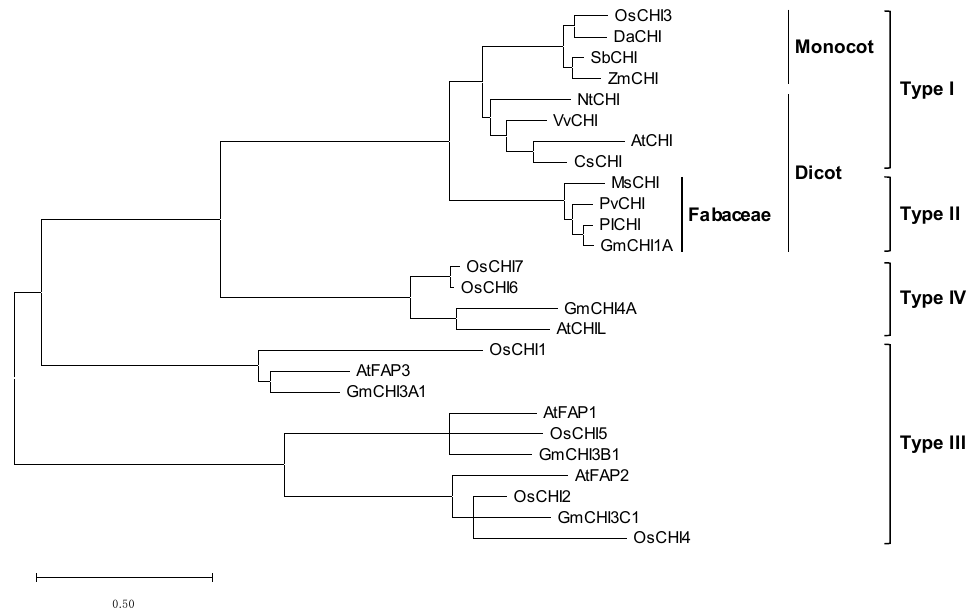
Figure 1. Phylogenetic analysis of OsCHIs and other plant CHIs. Amino acid sequences were aligned using Clustal W, and the phylogenetic tree was constructed by the maximum likelihood method using MEGA X. Scale bar denotes branch lengths measured in the number of substitutions per site. Amino acid sequences of plant CHIs used were DaCHI (CBX44252), ZmCHI (Q08704), SbCHI (XP_002463631), VvCHI (NP_001268033), AtCHI (P41088), NtCHI (NP_001312216), MsCHI (P28012), PlCHI (Q43056) GmCHI1A (NP_001235219), PvCHI (P14298), AtCHL (AY063786), AtFAP1 (Q9M1x2), AtFAP2 (Q84RK2), AtFAP3 (Q9C8L2), GmCHI3A1(NP_001238390), GmCHI3B1 (NP_001351383), GmCHI3C1 (Q43056), and GmCHI4A (AAT94362).